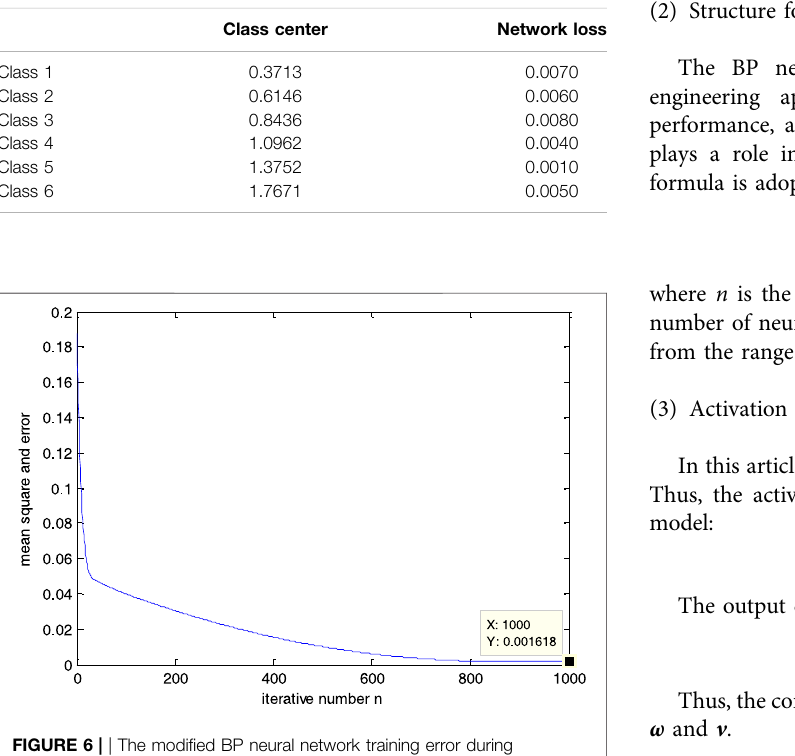
TABLE 2 | The class center and network loss.